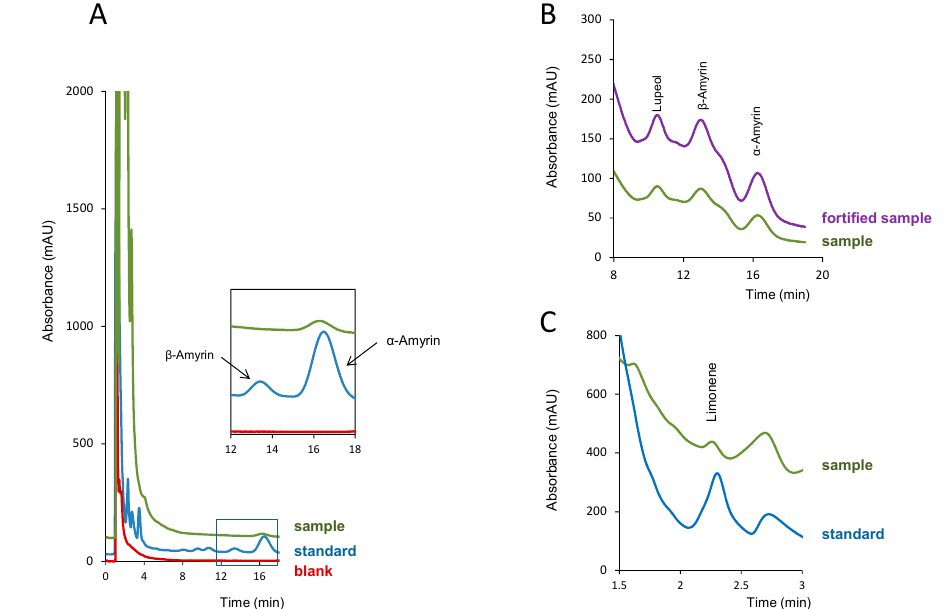
Figure 4. Chromatograms obtained in the analysis of the resin samples: ( a ) white copal, a standard solution of the analytes and a blank (methanol); ( b ) copal in tears (10 mg) and the same extract fortified with the analytes; ( c ) ocote resin diluted 1:20 with methanol and a standard solution of the analytes. Concentration of the analytes in the standard solution of ( a ) and ( c ), 5 µ g mL − 1 ; amount of the analytes added in the fortified sample of ( b ), 5 µ g mL − 1 . For other experimental details, see the